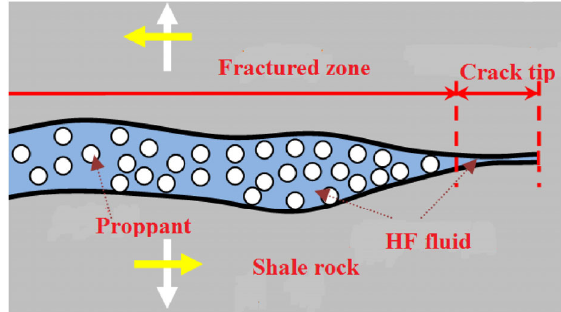
Fig. 1 Schematic illustration of the function of proppant in hydraulic fracturing.